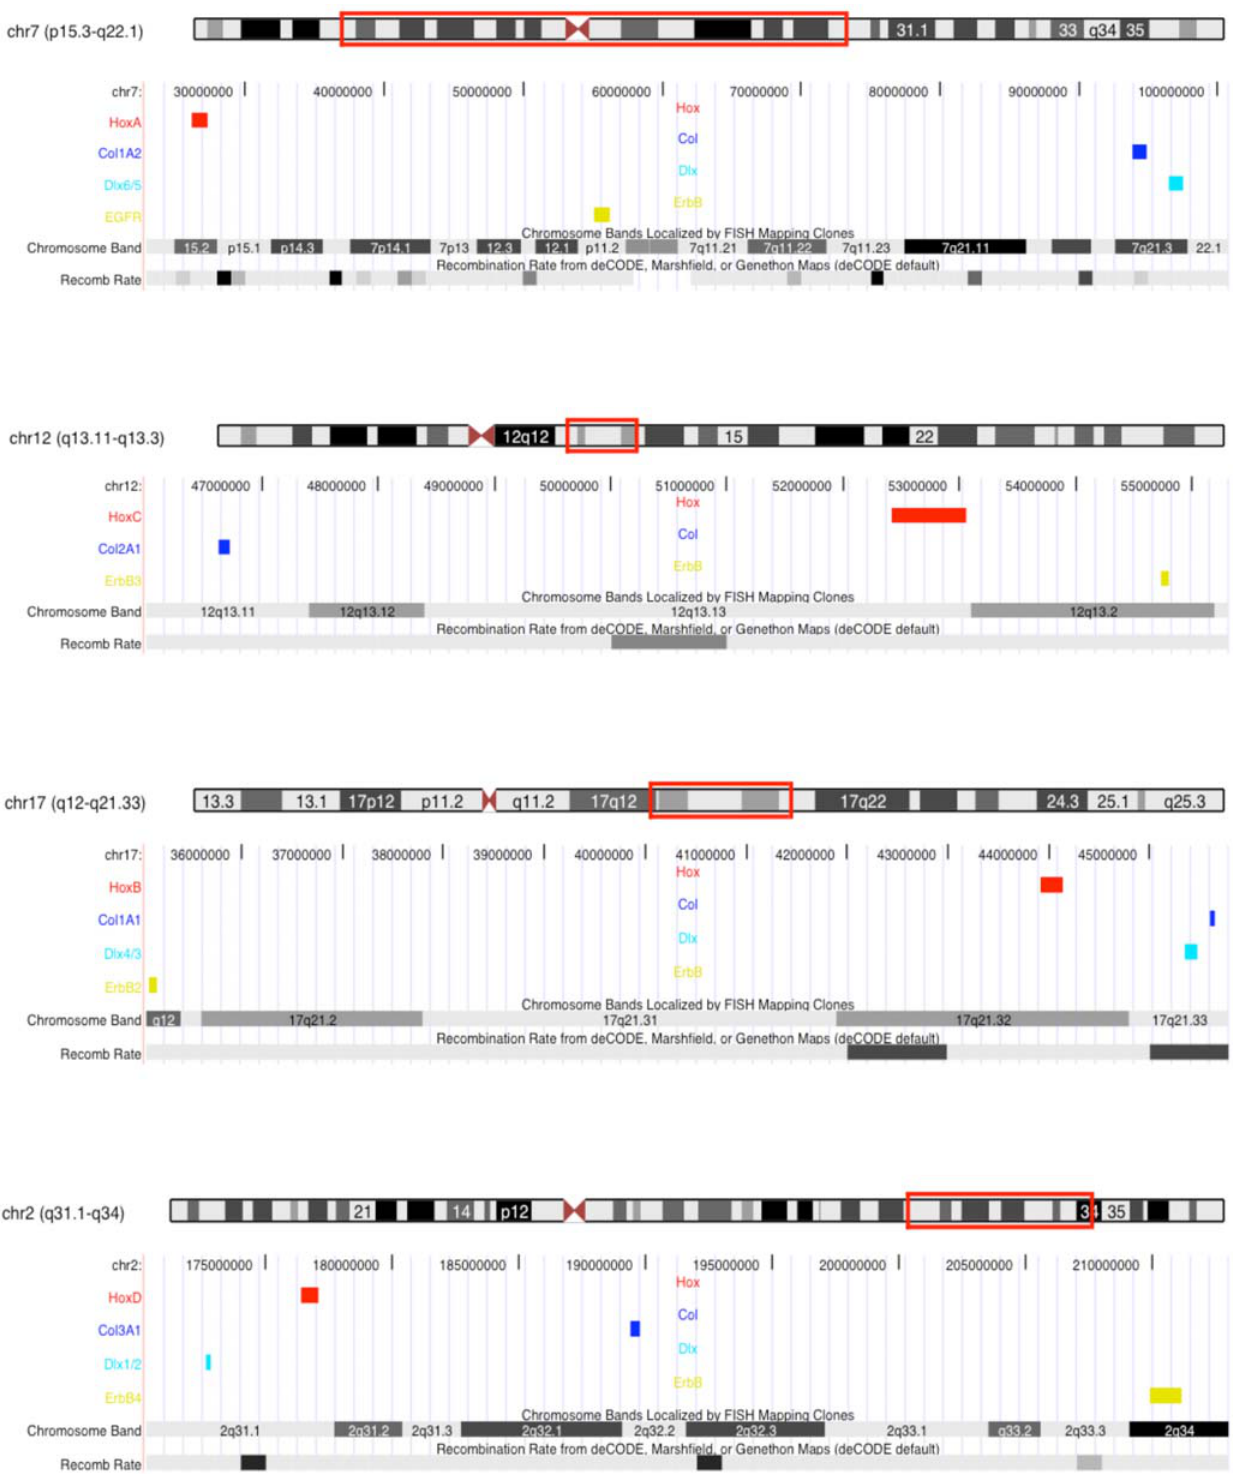
Figure 4. Recombination rate variation across human Hox paralogon containing chromosomes. The location of the Hox paralogon on human chromosome ideograms (human Chr7, Chr12, Chr17, Chr2) are boxed in red. Hox clusters are colored red, Col genes blue, Dlx genes light blue and ErbB genes green. The region below the ideograms corresponds to that region of the chromosome. Chromosomal bands are shown, as are the deCODE sex average recombination rate (Recomb Rate track) and repetitive element tracks. Darker gray bands in recombination rate track indicate higher than average recombination rates. Data from the UCSC genome browswer.